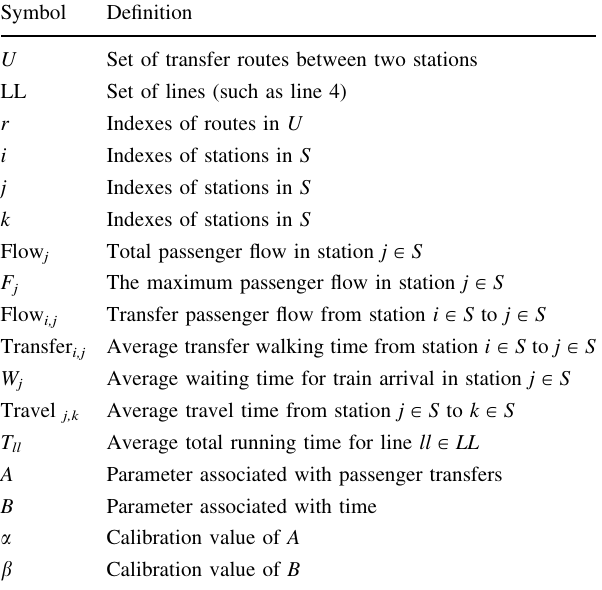
Table 2 Notations for congestion propagation rate model